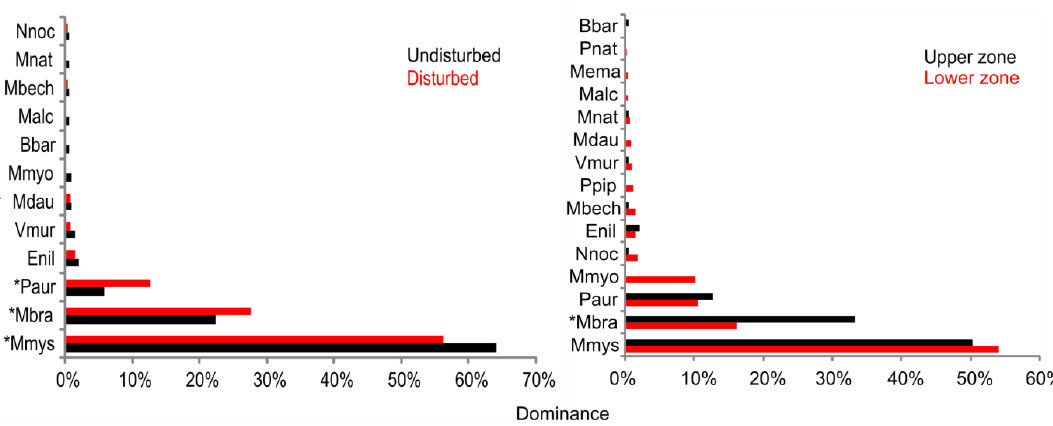
Figure 5. Dominance structure of bat assemblages recorded in the undisturbed and disturbed coniferous forests and the forests of the lower and upper zone in the Polish Tatra Mountains, 2016– 2020. Used symbols: * frequency of species significantly differing between forests ( p ≤ 0.05). For species abbreviations see description of Figure 2.